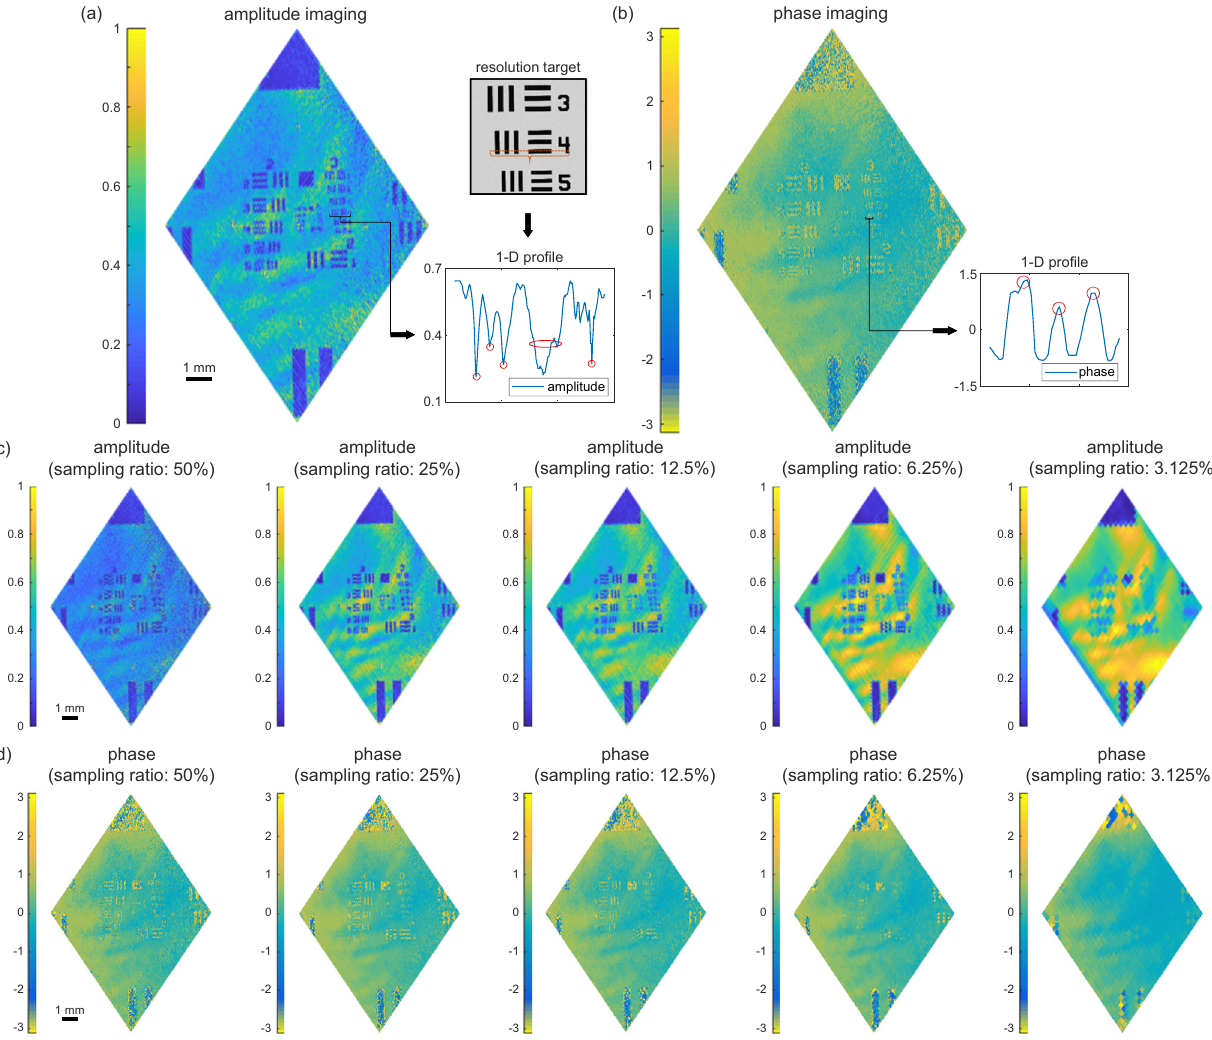
Fig. 1 Performance of the high-throughput SPH in large-FOV mode. A standard positive 1951-USAF resolution test target (R3L3S1P, Thorlabs) was used as a testing sample. 3 × 3 pixels binning strategy was adopted for 768× 768 pixels, leading to 256× 256 superpixels. a Reconstructed amplitude image of the resolution target. The upper inset: the image captured by conventional microscopy; the lower inset: the corresponding 1D pro fi le of element 4 of group 3. b Reconstructed phase image of the resolution test target. The corresponding 1D pro fi le is shown in the right inset. c , d The amplitude and wrapped phase images are reconstructed with different SRs of 50%, 25%, 12.5%, 6.25%, 3.125%. The corresponding scale bar is 1